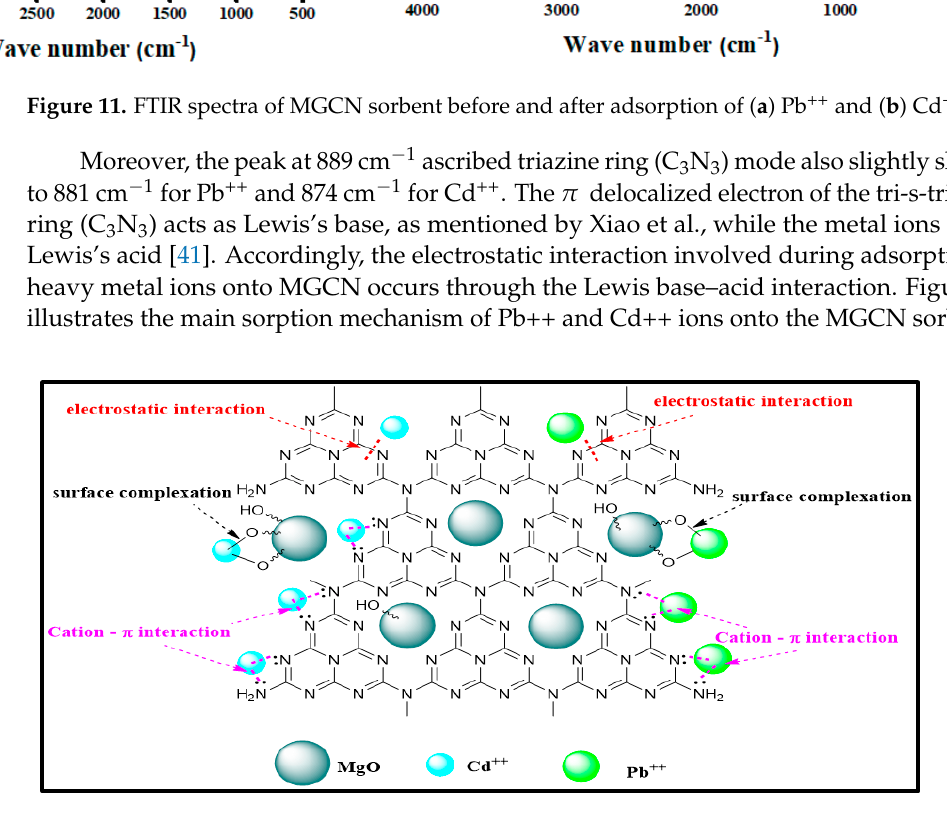
Figure 12. The main sorption mechanism of Pb++ and Cd++ ions onto MGCN sorbent. The adsorption optimum experimental conditions for removing Pb and Cd metal